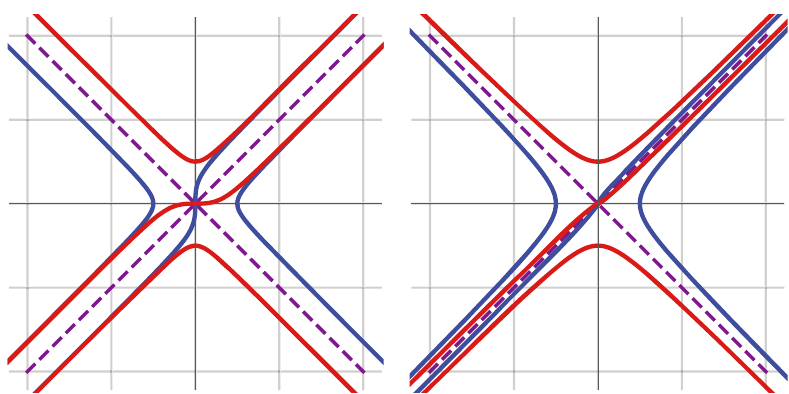
Figure 11: Lorentzian sinusoidal spirals in (cid:2) 2 with = n 2 ( left ) and = / n 1 2 ( right ) .